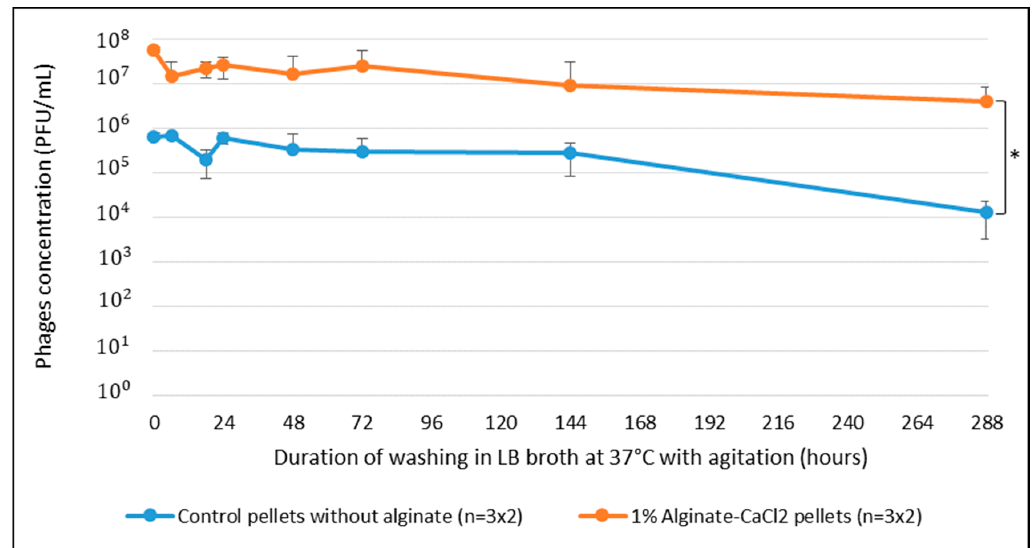
Figure 3. Evolution of phage concentrations in control and 1%-loaded CaCl 2 –alginate-hydrogel-coated β -TCP pellets after LB broth washing at 37 °C, under 170 rpm agitation for two weeks. * S ignificantly-different groups of results with p -value <0.05.